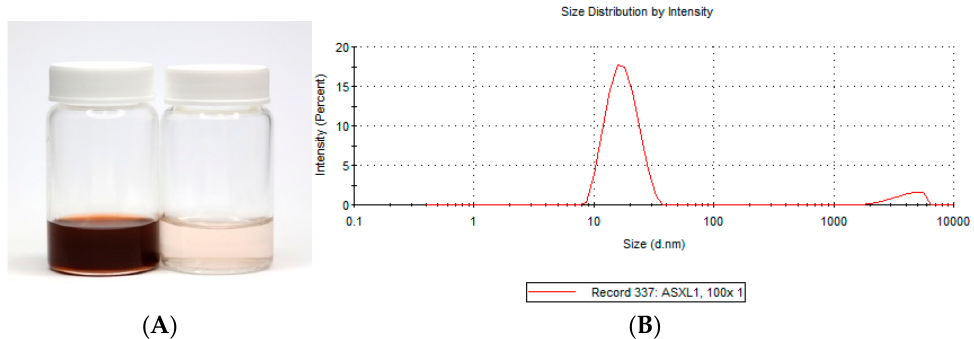
Figure 2. ( A ) Photographic image of SNEDDS–L1 (left) and SNEDDS–L1 diluted 100-fold by water (right). ( B ) Size distribution of SNEDDS–L1.